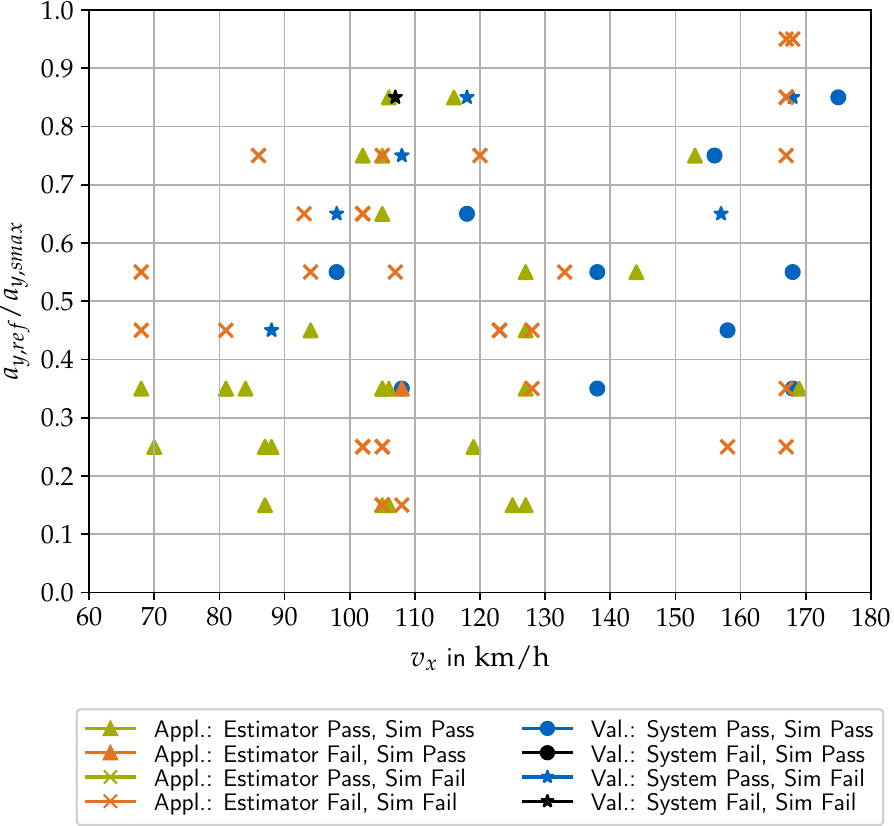
Figure 11. Type-approval decisions at all application scenarios for the nominal simulation (Sim) and for the error estimator and at all validation scenarios for the simulation and the real